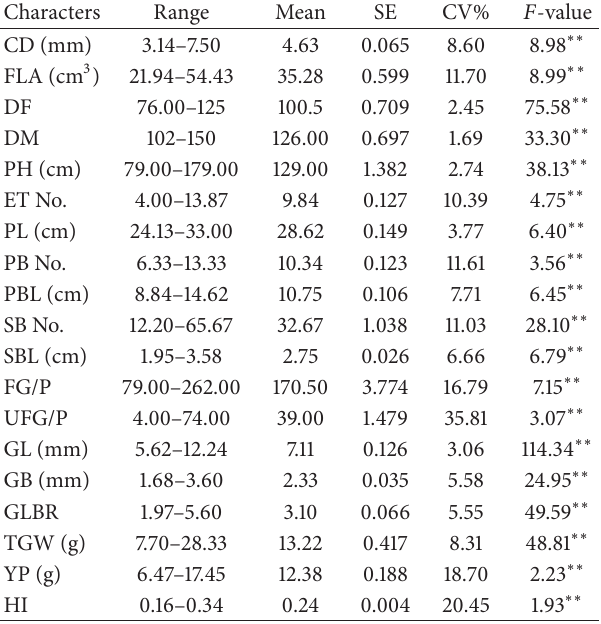
Table 4: Variability in different quantitative characters in 113 aromatic and fine rice